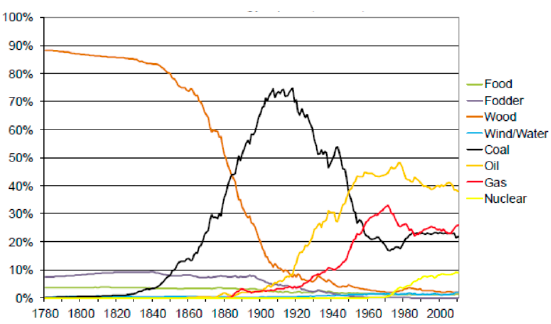
Figure 1. Transition of energy consumption in the U.S. 1780–2010 [17].